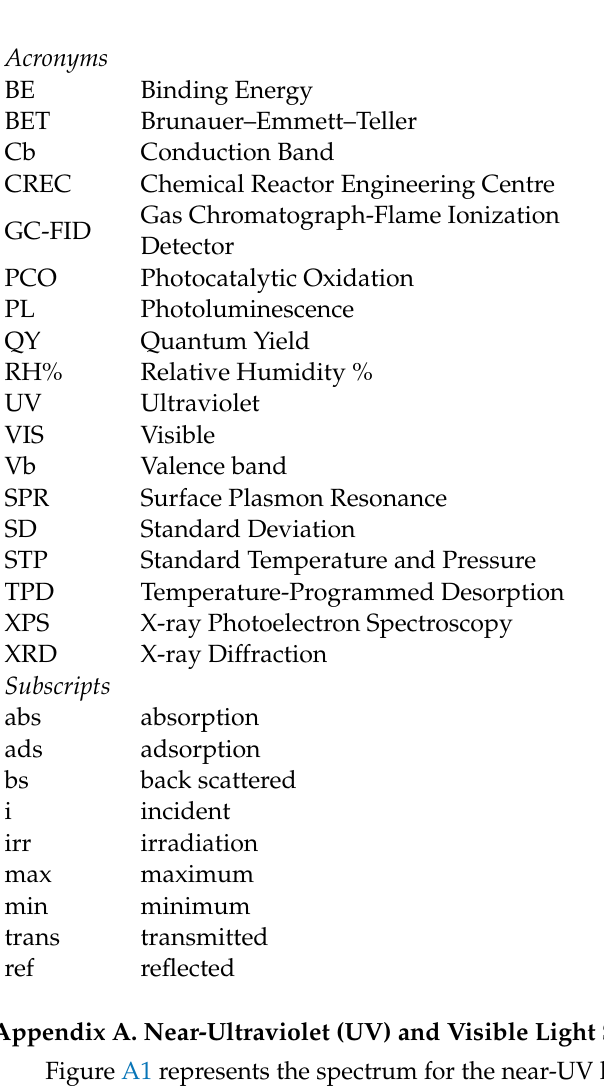
to 800 nm range.